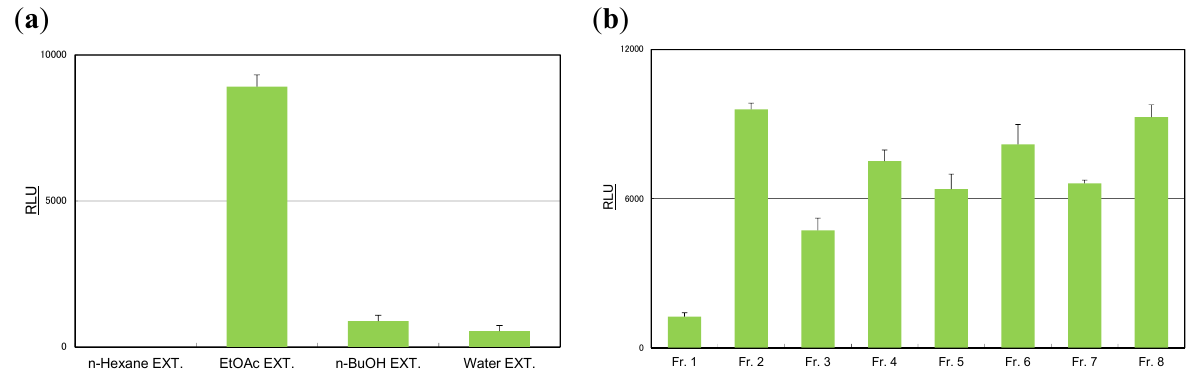
Figure 4. Induction of luciferase activity by rosemary extracts in the CALUX assay. ( a ) Extracts from rosemary. ( b ) Fractions from ethyl acetate extracts. Sample extracts were used at a final concentration of 100 μ g/mL. Results are expressed as means ± SDs.